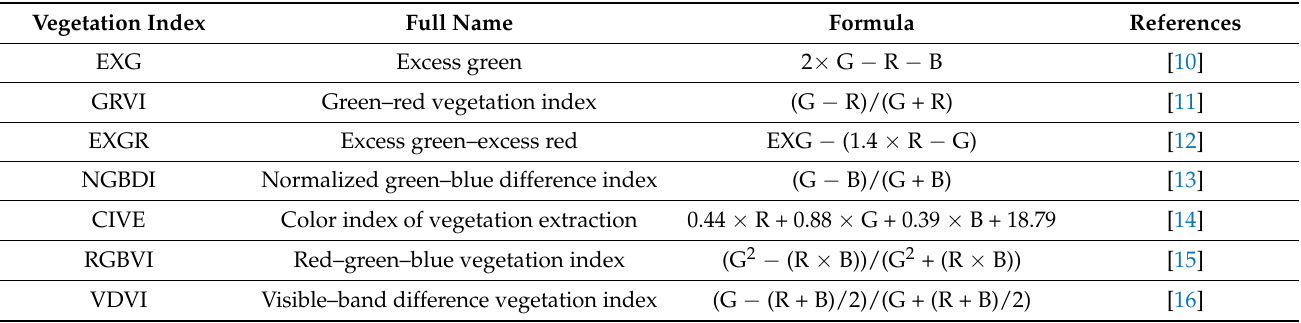
Table 1. Commonly used visible vegetation